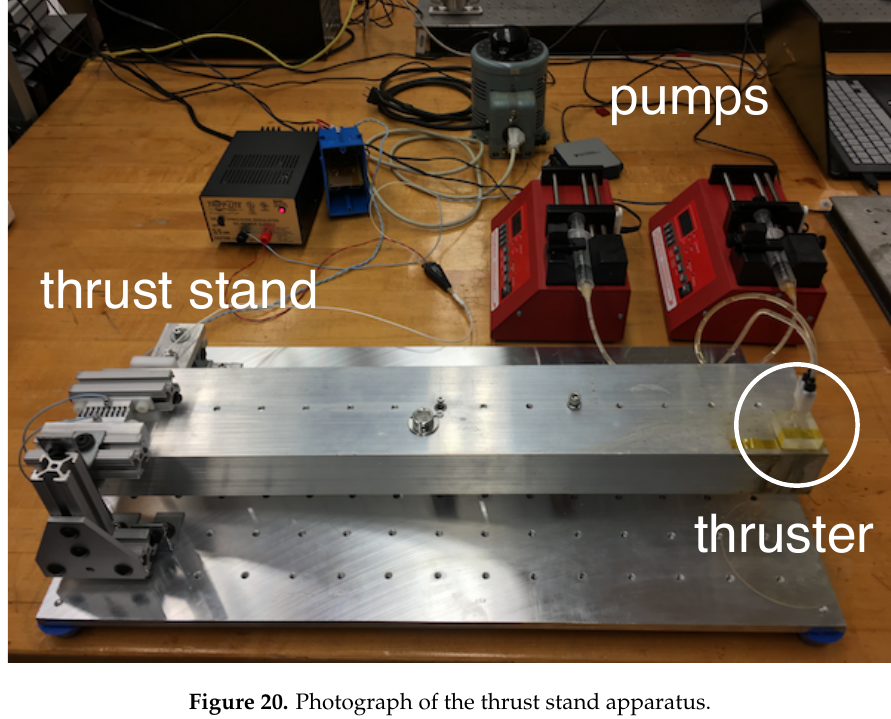
Figure 20. Photograph of the thrust stand apparatus.